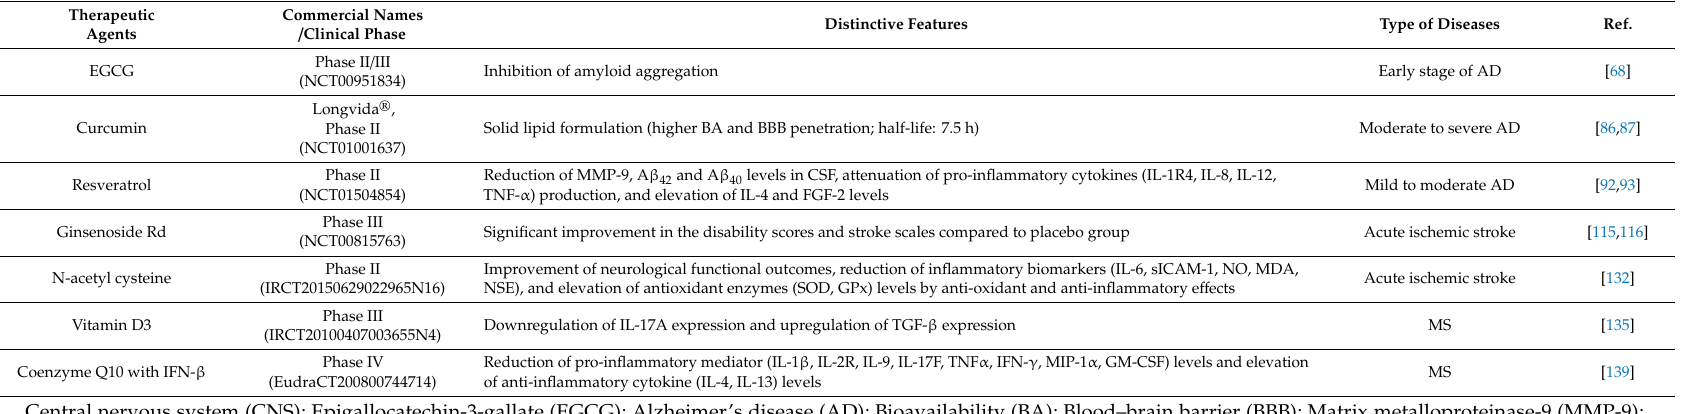
Table 2. Natural compounds in the commercial market or clinical trials for the treatment of CNS